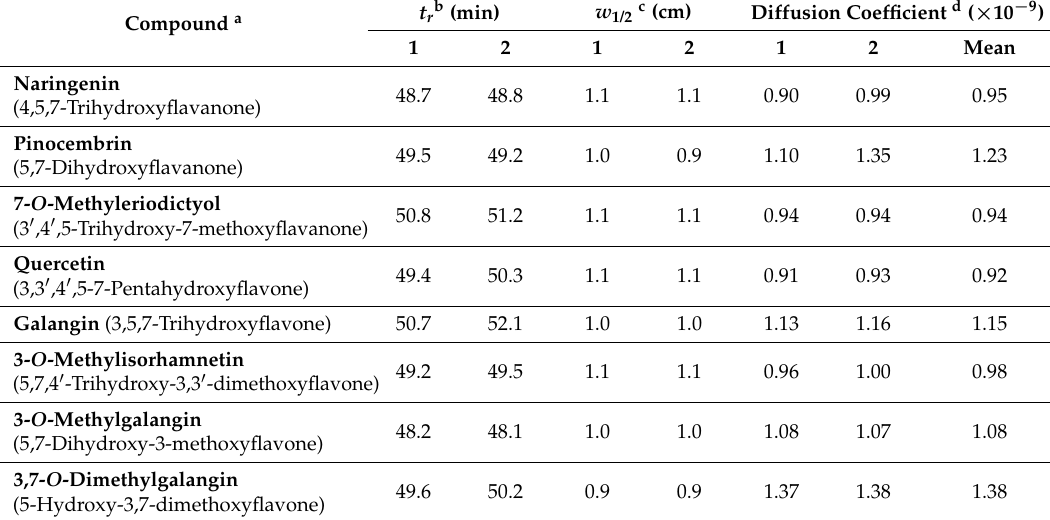
Table 2. Diffusion coefficients determined by the Taylor-Aris dispersion technique.